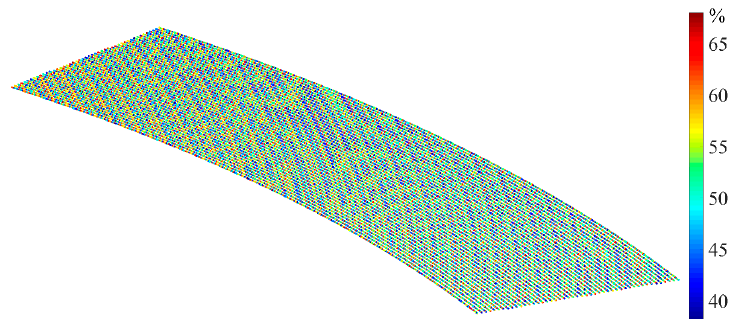
Figure 11. The improvement ratio in the compensation results compared to benchmark data.